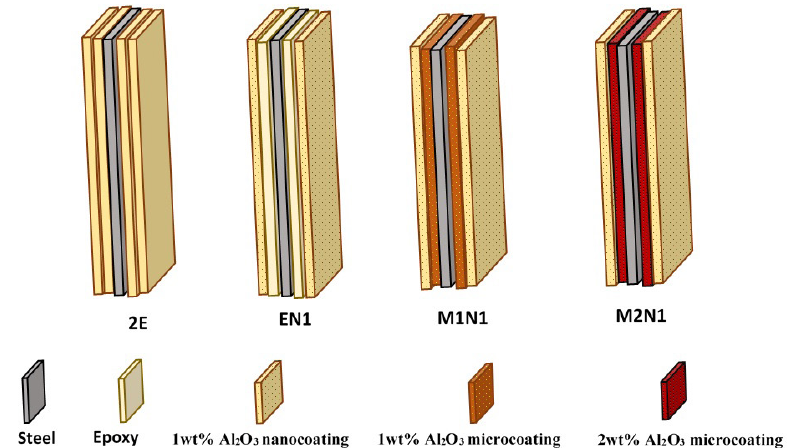
Figure 1. The final types of micro/nano coatings on steel